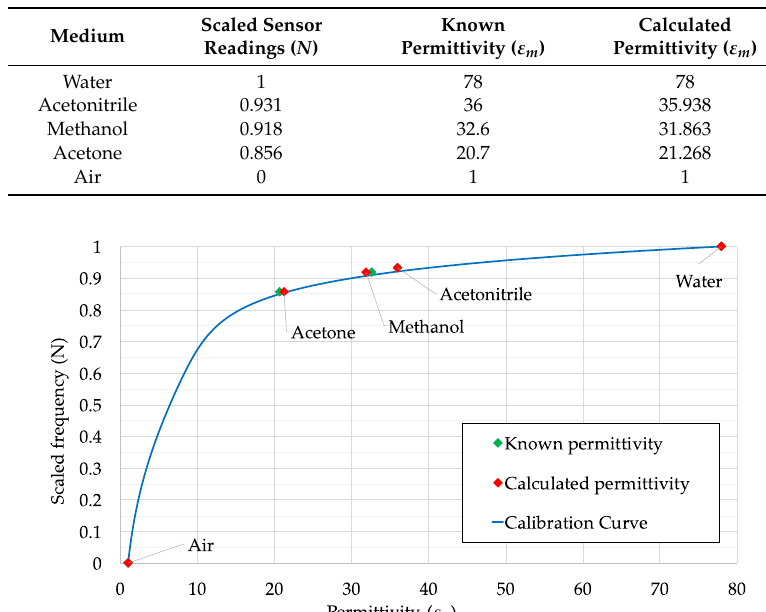
Table 4. The values of known and calculated permittivity.